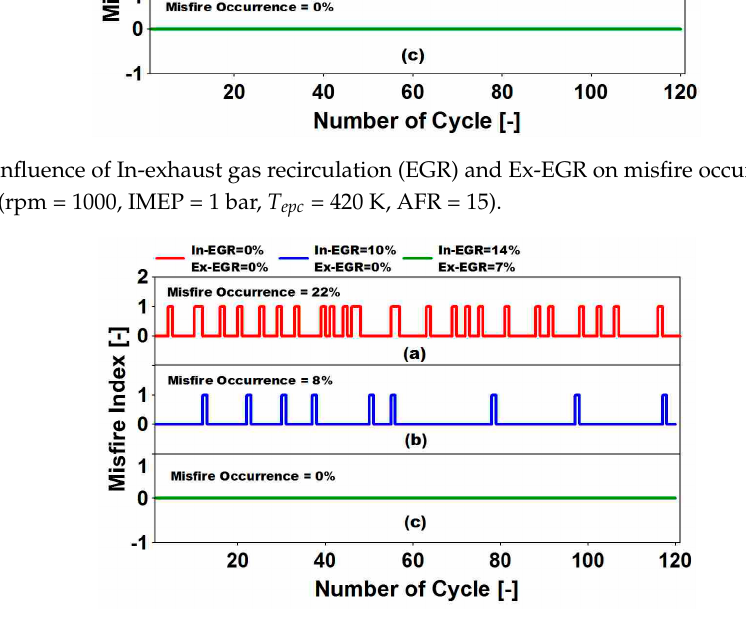
Figure 4. Influence of In-EGR and Ex-EGR on misfire occurrence at low-load condition (rpm = 2000, IMEP = 1.5 bar, T epc = 431 K, AFR = 14.5).